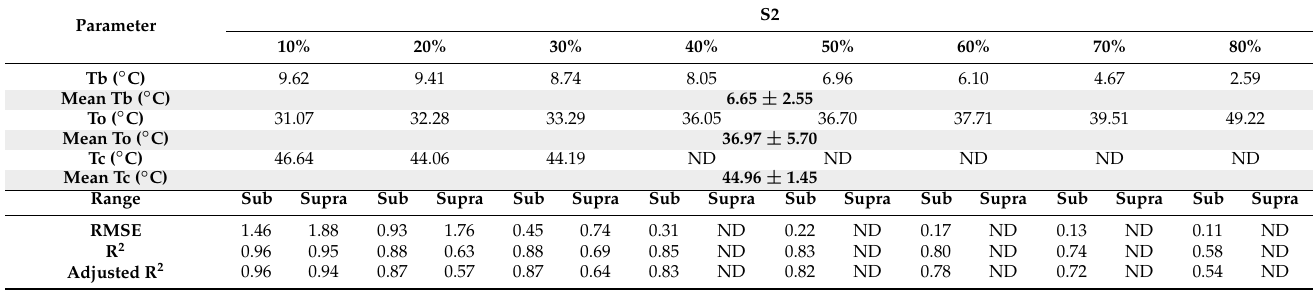
Table 4. Estimated parameters for the segmented model (S2) of Salvia hispanica seeds. Root mean square of deviations (RMSE) and coefficient of determination (R 2 ) for the relationship between emergence